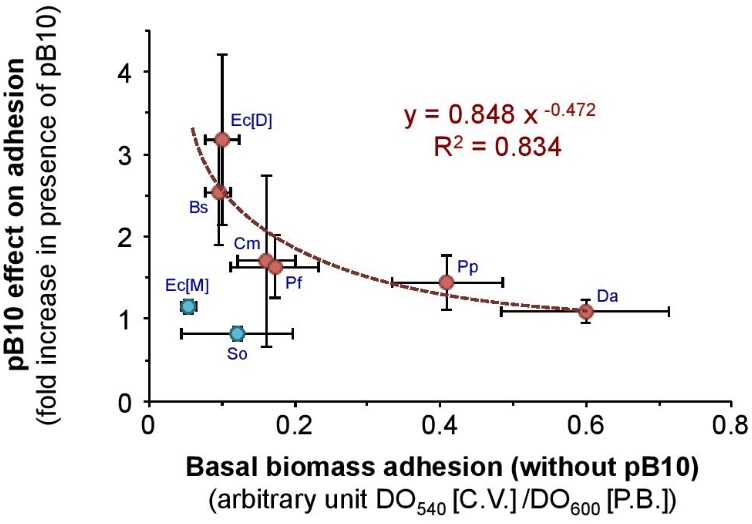
Gain in biofilm formation for pB10-bearing bacteria. Biofilm formation was compared for isogenic strains with and without the IncP-1β plasmid pB10: B. subtilis CM291 (Bs); C. metallidurans AE815 (Cm); D. acidovorans (Da); E. coli DH5α (Ec[D]), E. coli MG1655 (Ec[M]); P. fluorescens CM292 (Pf); P. putida SM1443 (Pp); S. oneidensis CM87 (So). Error bars indicate the standard error of the means (n = 3). The dotted line represents a regression curve related to a Spearman correlation without considering strains MG1655 and MR-1 showing that the effect of pB10 carriage on adhesion is stronger as the basal level of biofilm formation is initially low in the absence of plasmid (r = -0.943, p = 0.02). The equation of the regression curve is indicated.